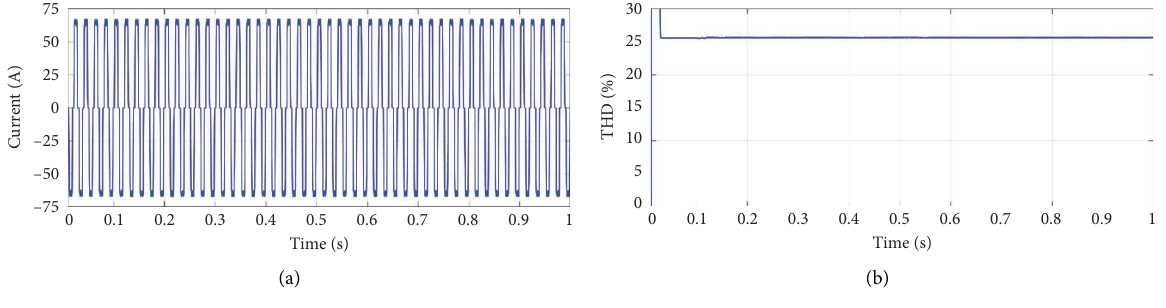
Figure 22: Load current (a) and its THD (b).